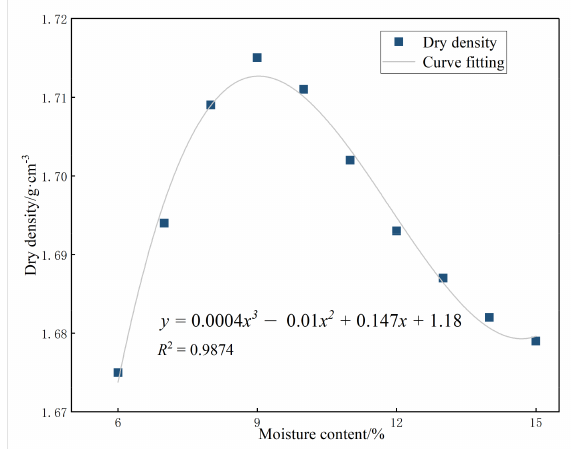
Figure 3. Compaction curve of solidified aeolian